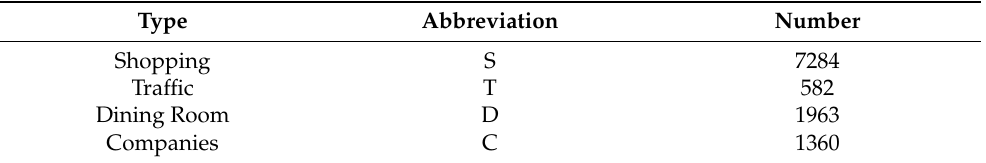
Table 2. In the real data, the number and category of 4 kinds of